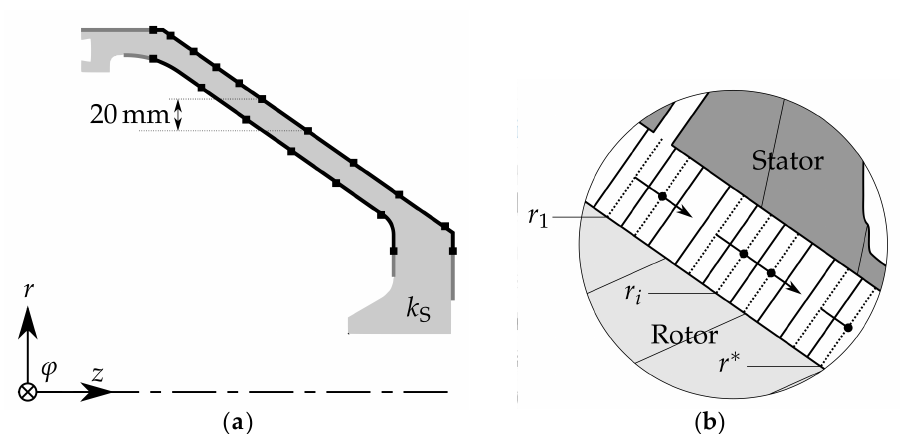
Figure A1. Boundary conditions of finite-element model and discretization of the rotor-stator system. ( a ) Finite-element model including boundary conditions: interpolated temperature and measurement point ( ), extrapolated temperature ( ). ( b ) Discretization of the rotor-stator gap to calculate the adiabatic wall